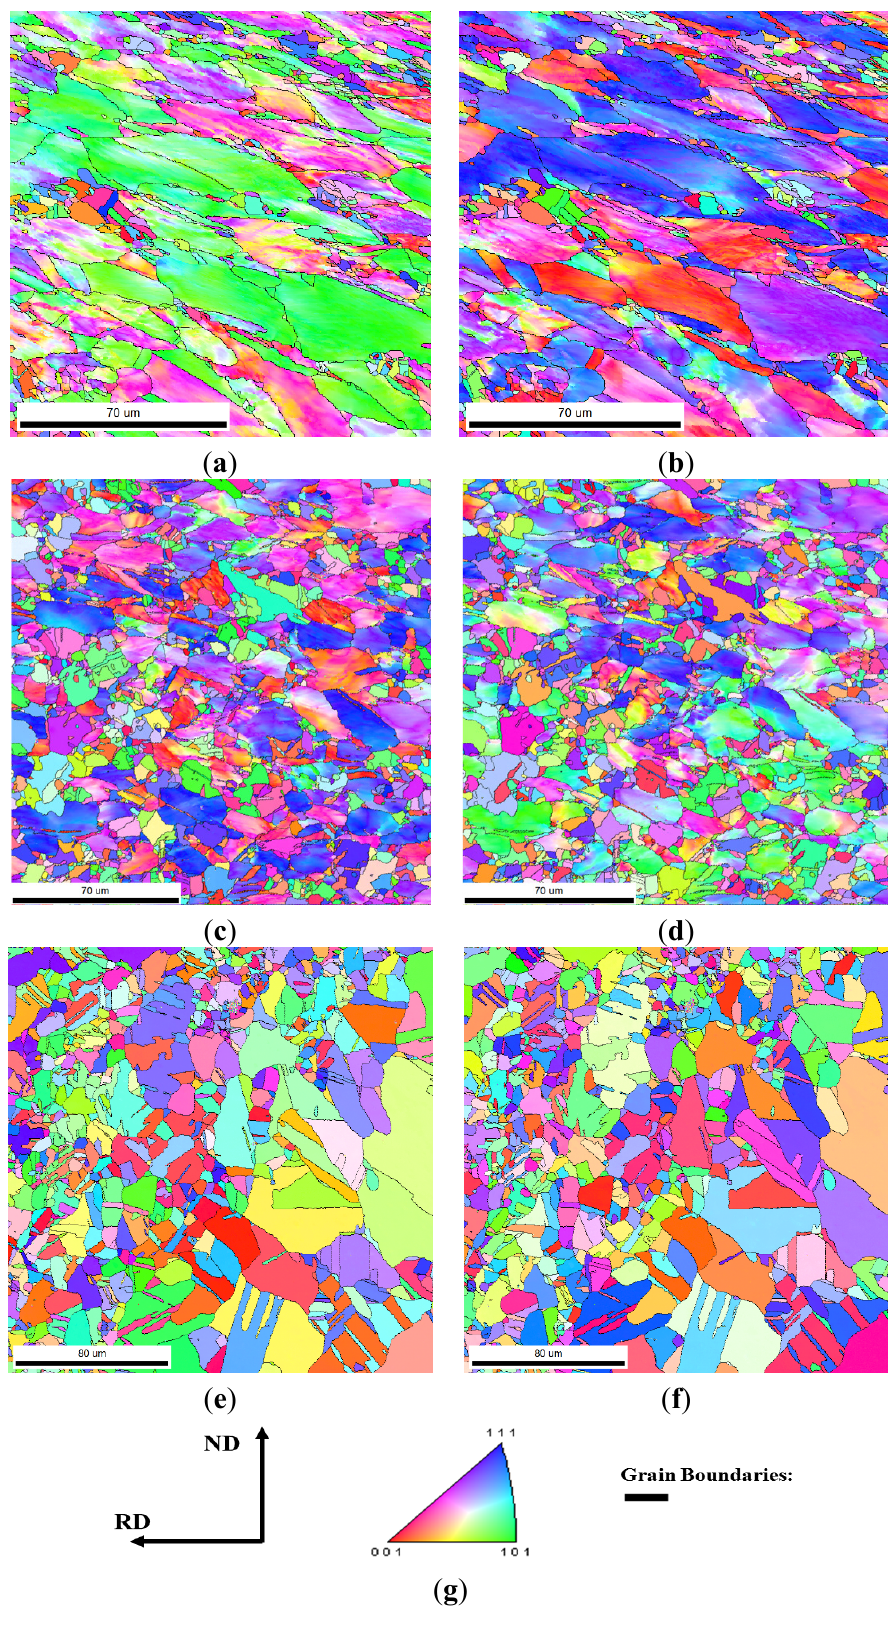
Figure 4. Inverse pole figure (IPF) maps of 50% cold-rolled FePd alloy after 700 °C annealing for ( a , b ) 1 min; ( c , d ) 2 min; and ( e , f ) 48 h. ( g ) The sample coordinates of ND and RD, and the corresponding color coding of the IPF in terms of